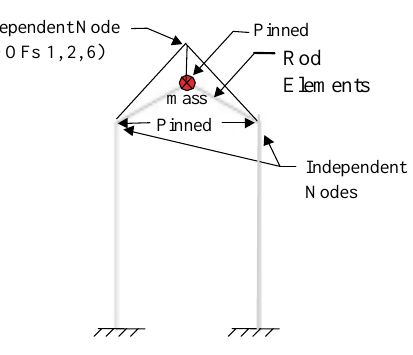
Fig. 5. Rigid case.